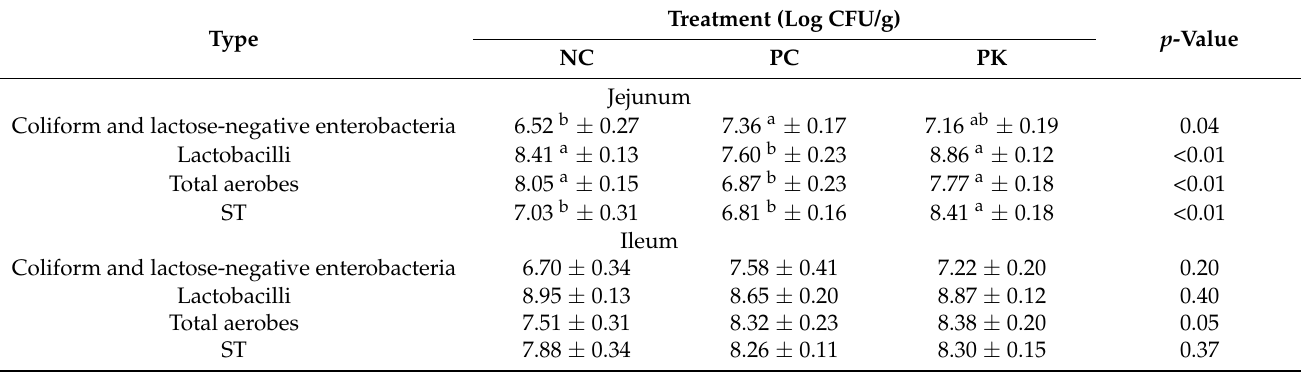
Table 5. Dietary supplemental effect of P. konkukensis on intestinal microbiota in